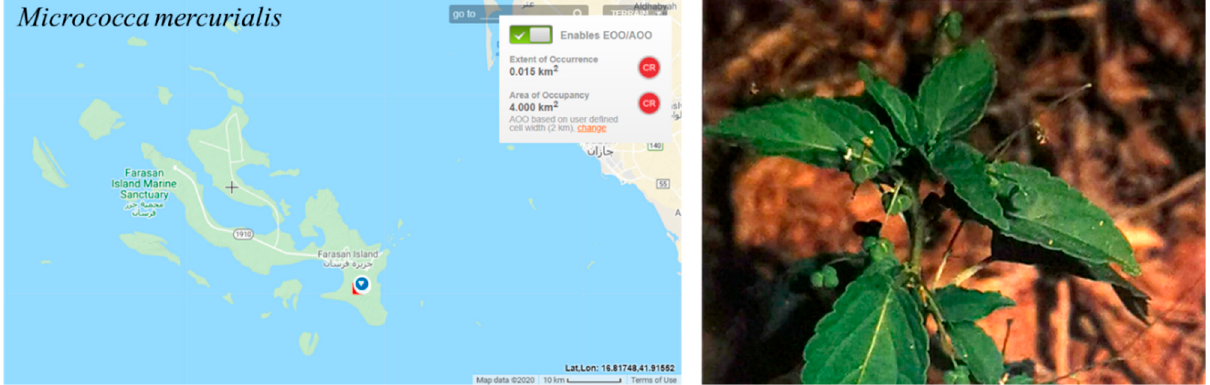
Figure 12. Geographical distribution of Micrococca mercurialis in the Farasan Archipelago. Plant photo reproduced with permission from Collenette [7] .